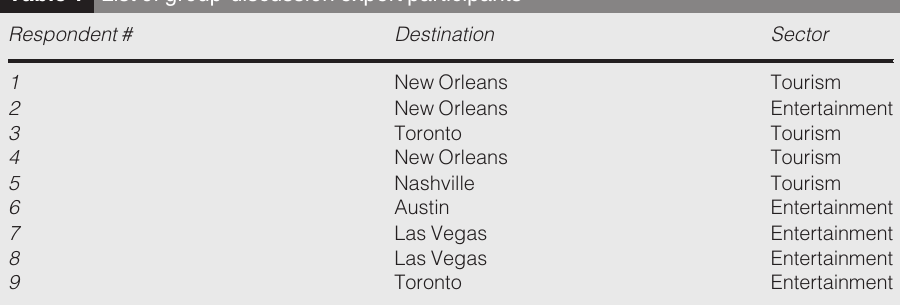
Table 1 List of group-discussion expert